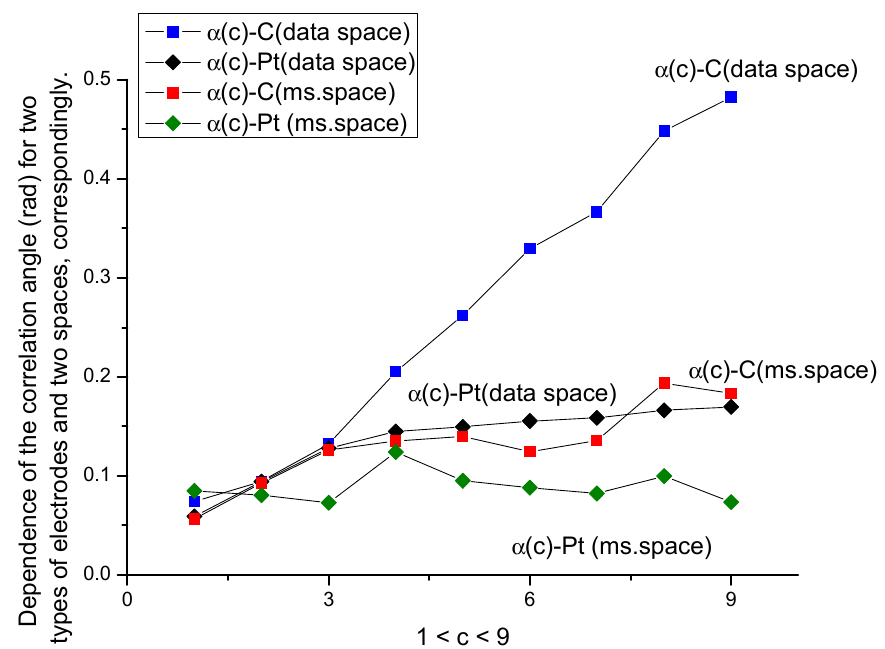
Figure 6. Behavior of the correlation angle α ( c ) for two types of electrodes in data and measurement spaces. We observe the monotone behavior for C- and Pt-electrodes in data space, while, for the measurement space, these curves for both types of electrode completely lost their monotone behavior.